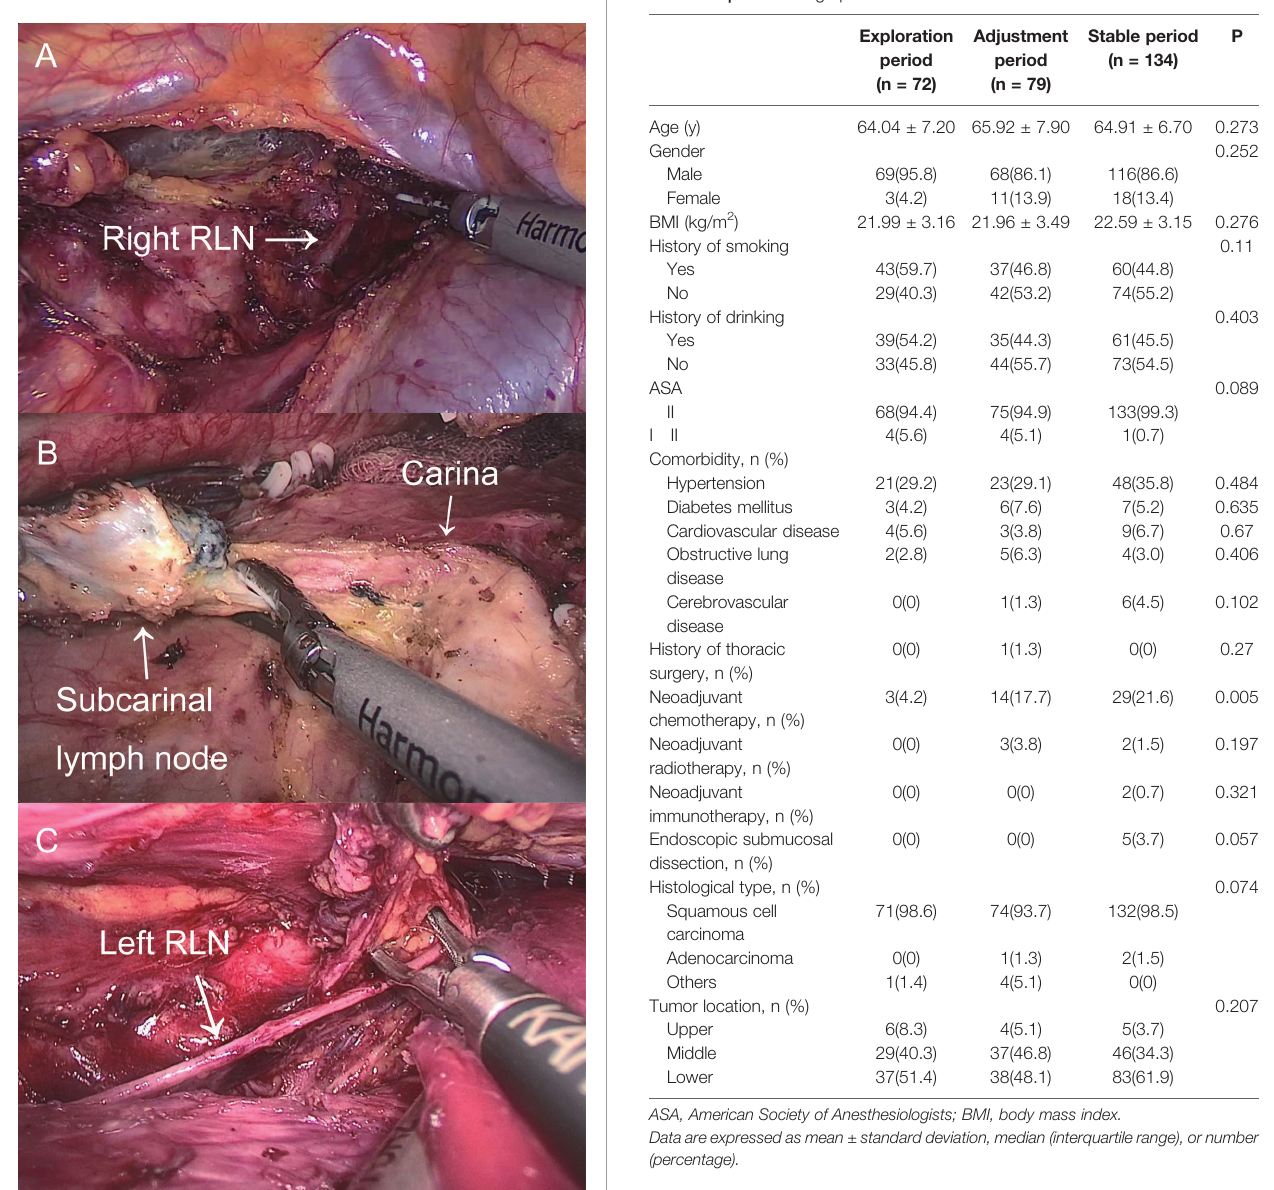
TABLE 1 | The demographics and tumor characteristics of the overall